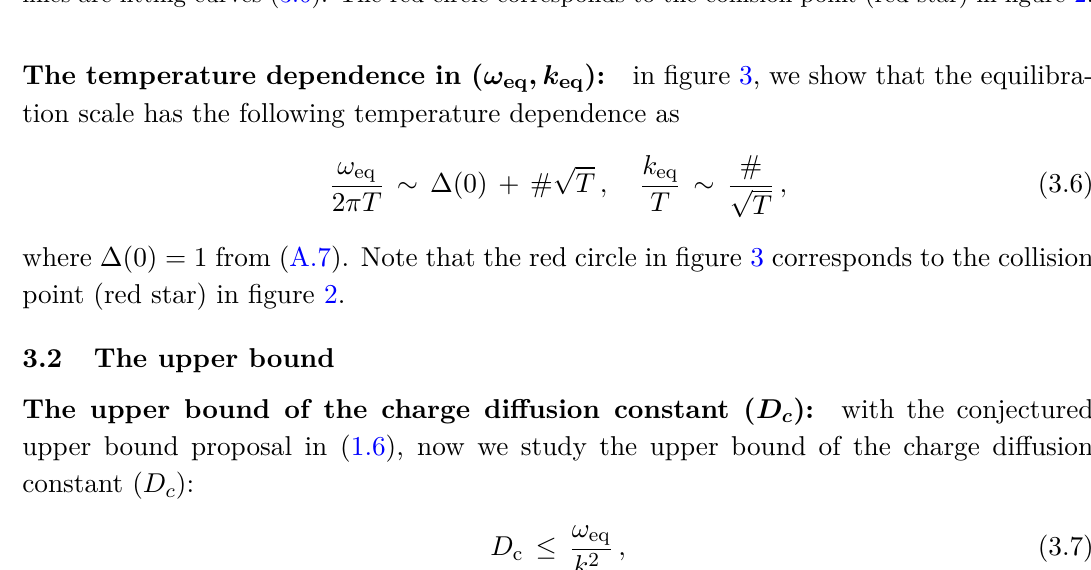
Figure 3 . The temperature dependence of ω eq and k eq . Dots are numerical data and the solid lines are fitting curves (3.6). The red circle corresponds to the collision point (red star) in figure